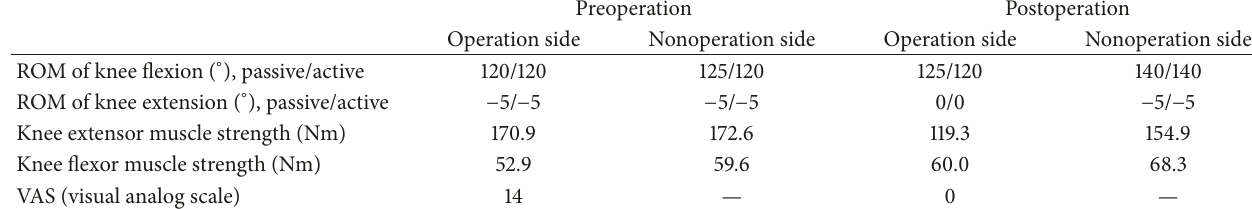
Table 2: Pre- and postoperative range of motion (ROM), muscle strength, and VAS.